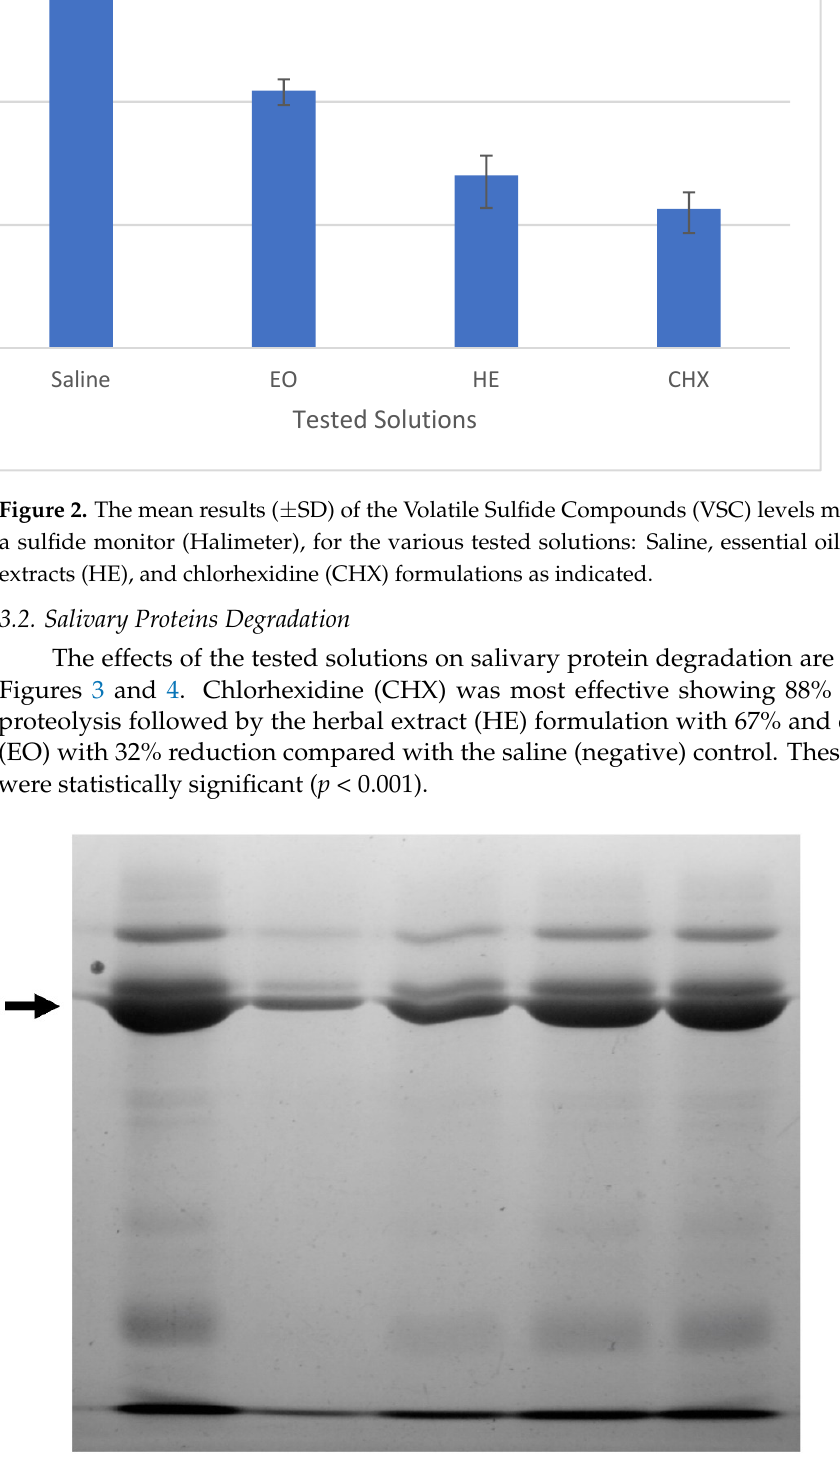
Figure 3. SDS-PAGE analysis of the salivary proteins (arrow, alpha amylase, 55 KD) in the incubation mixture following pre-disinfection of the PMMA discs using the various treatment solutions with lane designations as follows: (1) Filtered saliva control, (2) saline control, (3) essential oils treatment, (4) herbal extracts treatment, and (5) chlorhexidine treatment.